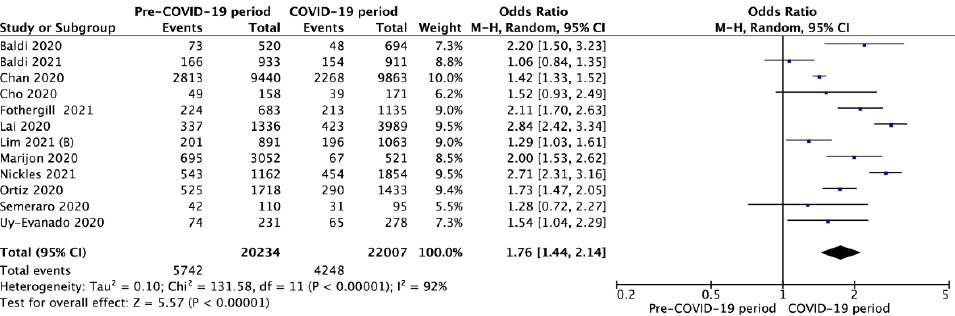
Figure 5. Forest plot of survival to hospital admission rate in pre- vs. intra-COVID-19 periods. The center of each square represents the weighted odds ratios for individual trials, and the corresponding horizontal line stands for a 95% confidence interval. The diamonds represent pooled results. Legend: CI = confidence interval; OR = odds ratio.